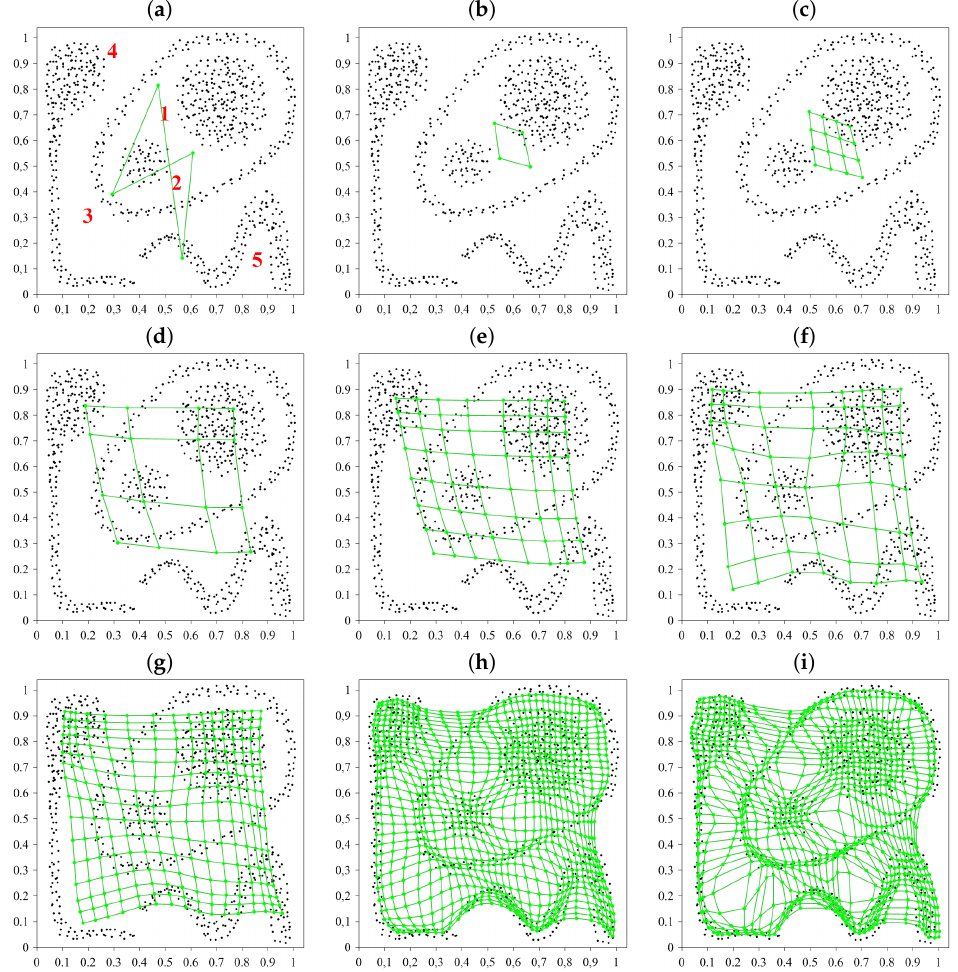
Figure 10. The evolution of GSOM in the synthetic data set of Figure 6a in learning epochs: ( a ) No. 0 (start of learning), ( b ) No. 1, ( c ) No. 2, ( d ) No. 3, ( e ) No. 4, ( f ) No. 5, ( g ) No. 6, ( h ) No. 10, and ( i ) No. 1000 (end of learning).